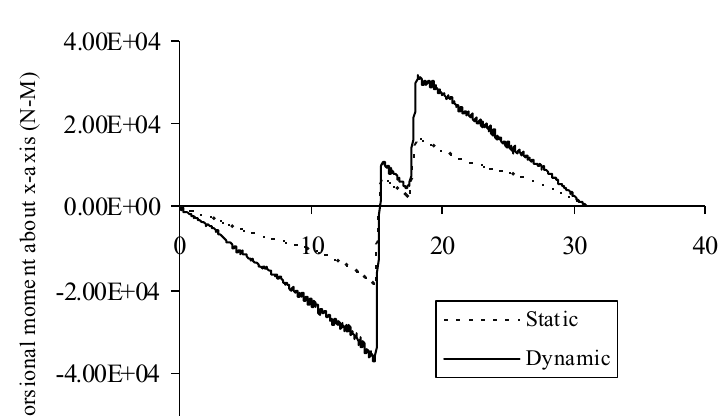
Fig. 12. Time histories for shear force.